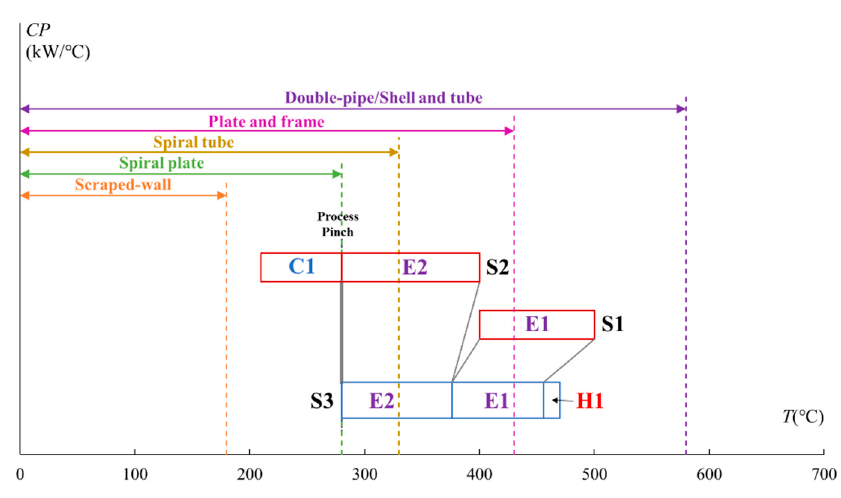
Figure 3. SRTGD-STR of the first retrofit plan for Example 1.